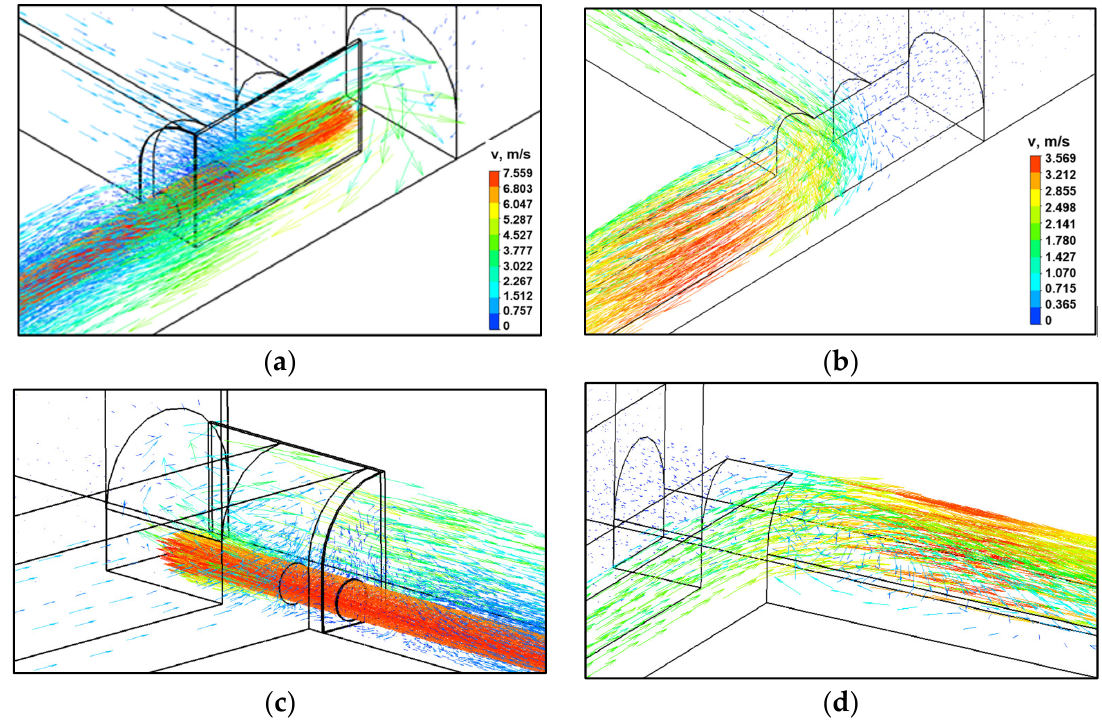
Figure 8. The distributions of velocity vectors for the air flowing through the intersection of the longwall and the tailgate with built-in AVE ( a , c ) and without such equipment ( b , d ). In the case of the system with auxiliary ventilation equipment, the air stream flowing out of the longwall hits the air brattice (ventilation curtain) located in the tailgate. After it bounces off, the air stream travels towards the unliquidated section of the tailgate located behind the caving line of the longwall and hence also towards the goaf with caving. This leads to the formation of a gyrating flow and recirculation of air at the outlet from the longwall. Such a flow generates large curvatures of the current line. Two air streams overlap in this section of the tailgate: the main stream flowing out of the longwall and the refreshing stream flowing out of the auxiliary air duct. This leads to significant changes in the distribution of methane concentrations in this area (Figure